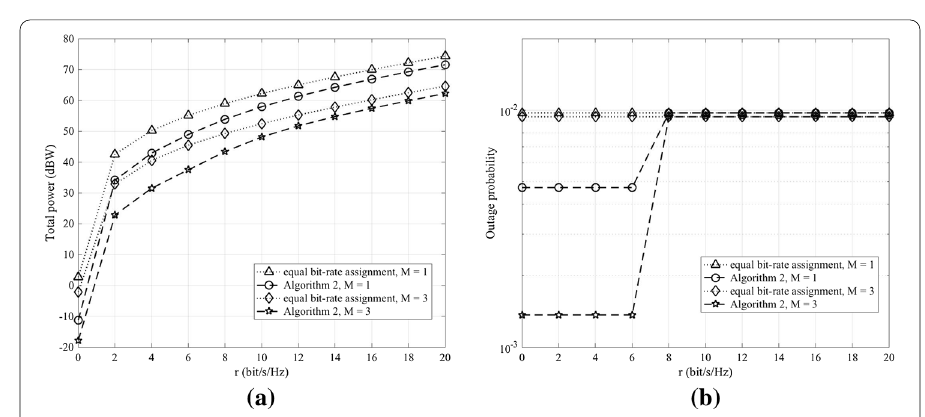
Fig. 5 Total transmit power and outage probability versus r , where d AR = 0.1 , K = 16 and Q out = 0.01